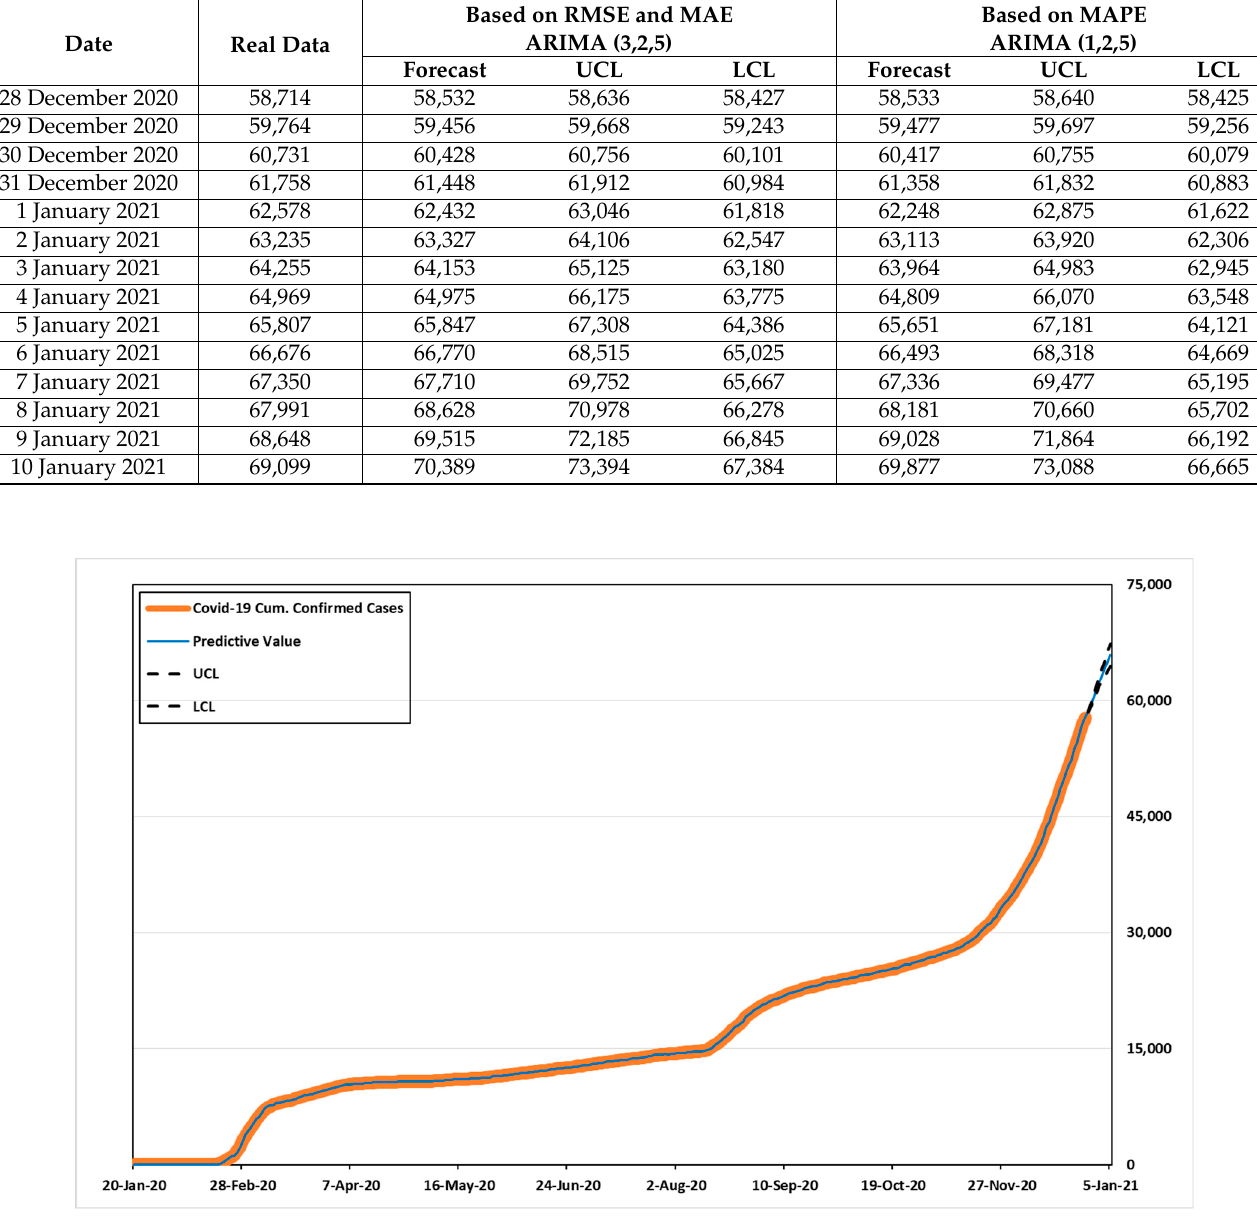
Figure 3. Time ‐ series plot for ARIMA (3,2,5). Figure 3. Time-series plot for ARIMA